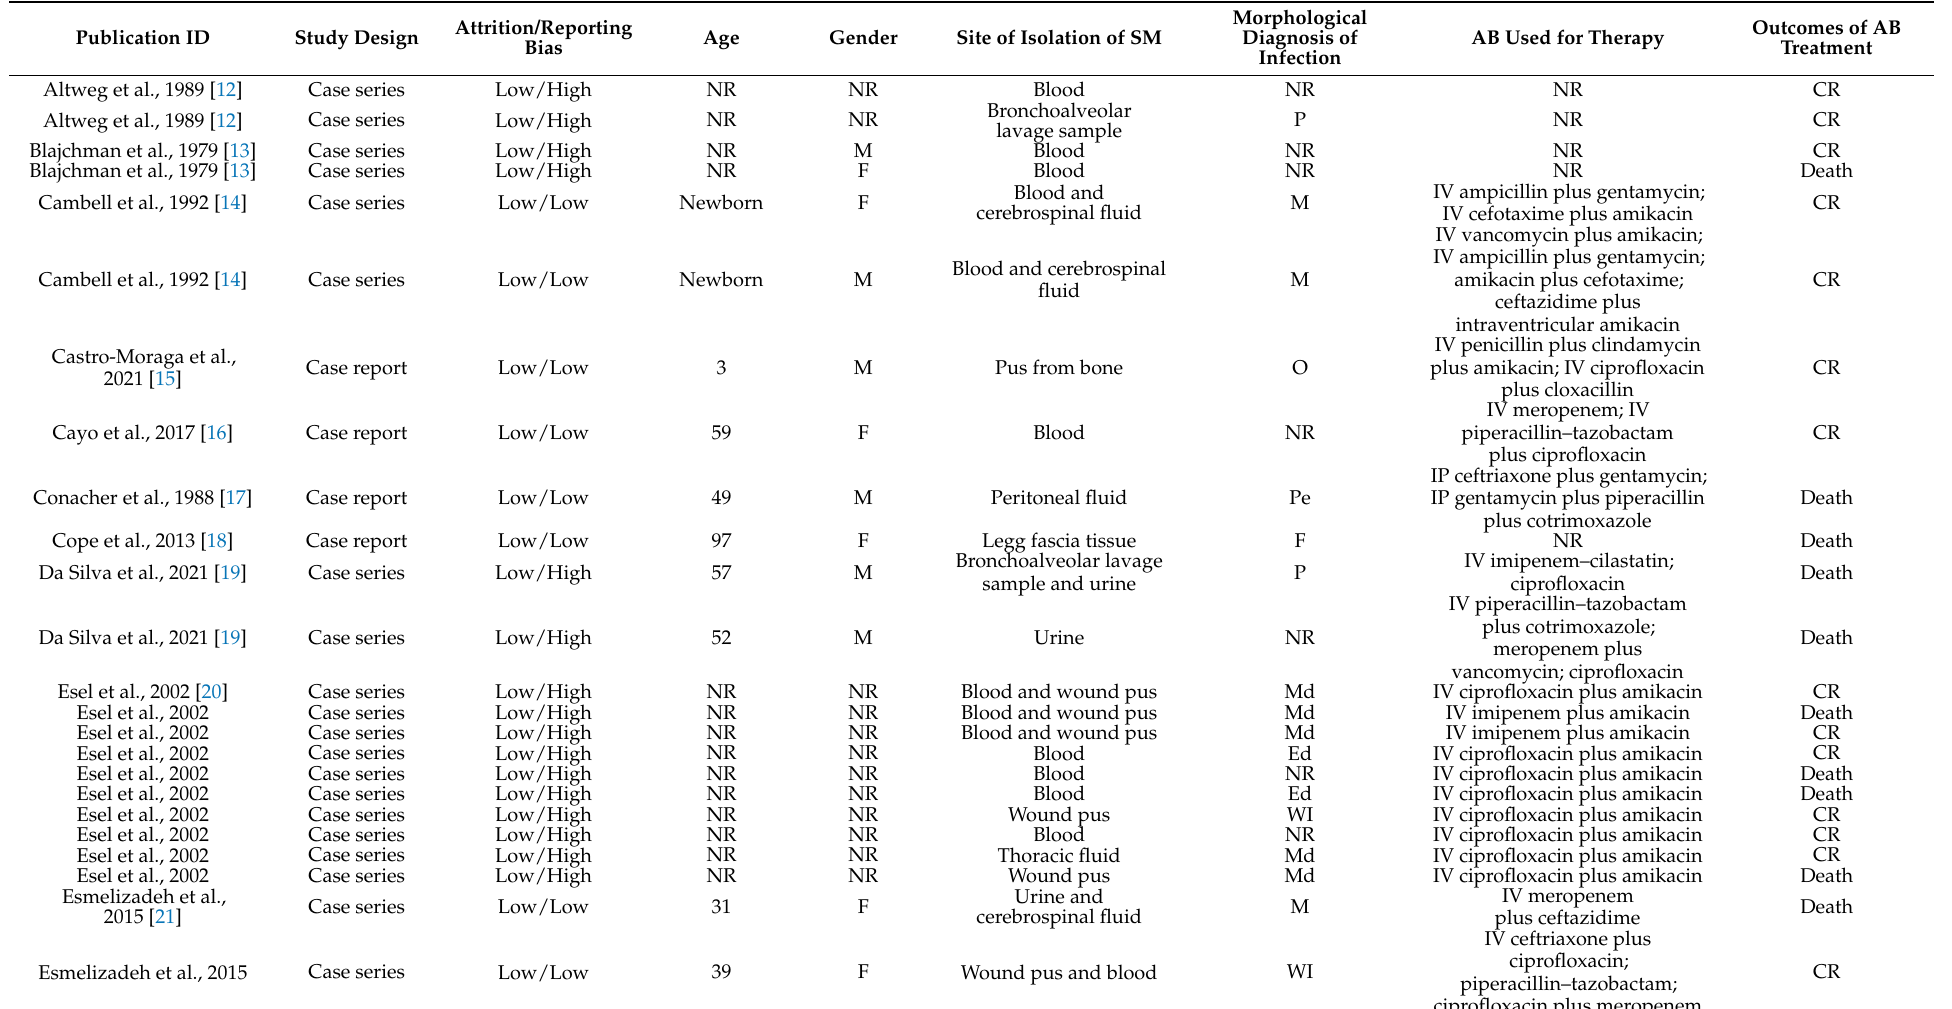
Table 1. Overview of the reported Serratia marcescens